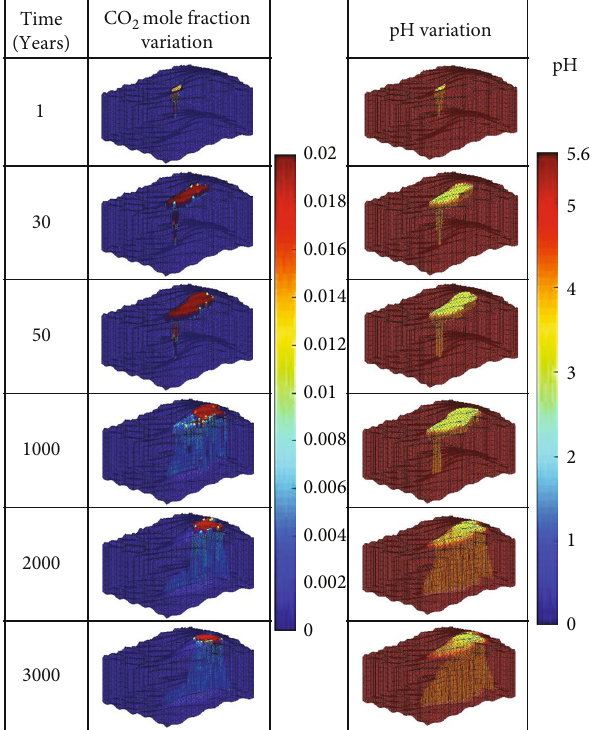
Figure 5: Illustration of CO geological time scale during CO